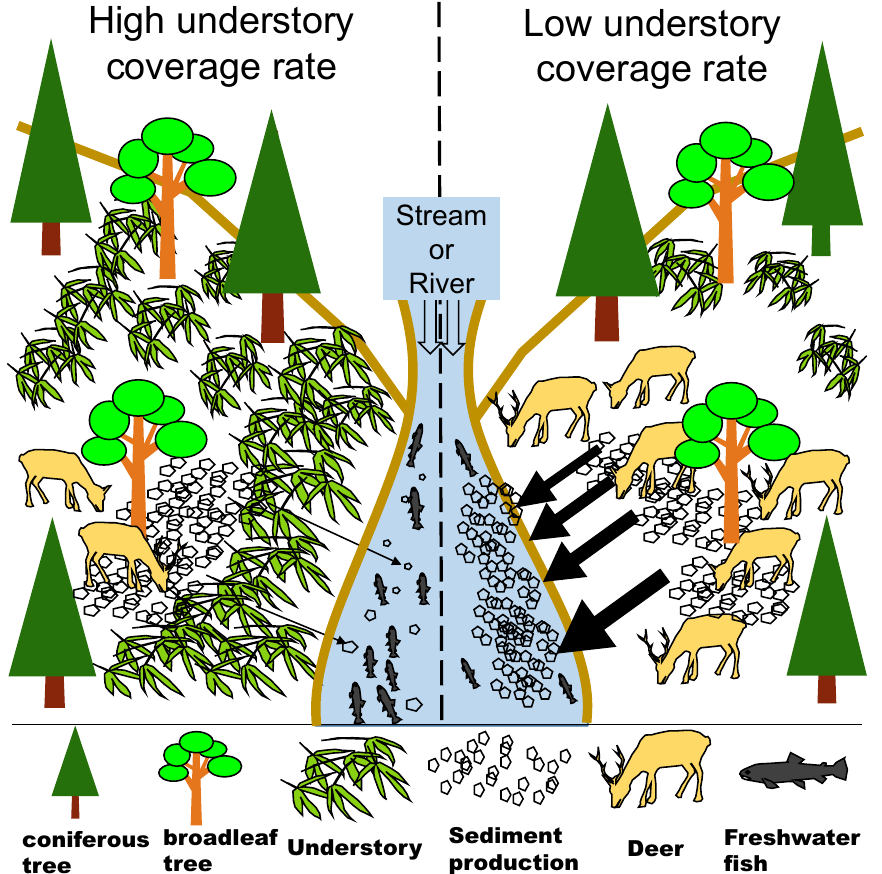
Figure 2. The concept ecosystem image diagram of the relationship between understory coverage rate and sediment production in the low mountain forest area. The understory disturbs sediments moving. The concept image diagram was drawn by T. Mizuno using Microsoft